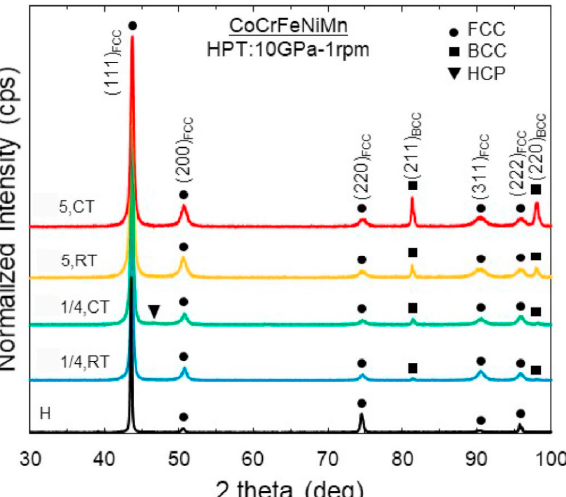
Figure 7. XRD patterns of the homogenized condition (H) and near the edges of the disks processed by N = 1/4 and 5 turns HPT at RT and 77 K (CT). Reprinted with permission from Ref. [117]. Copyright 2021 Elsevier.